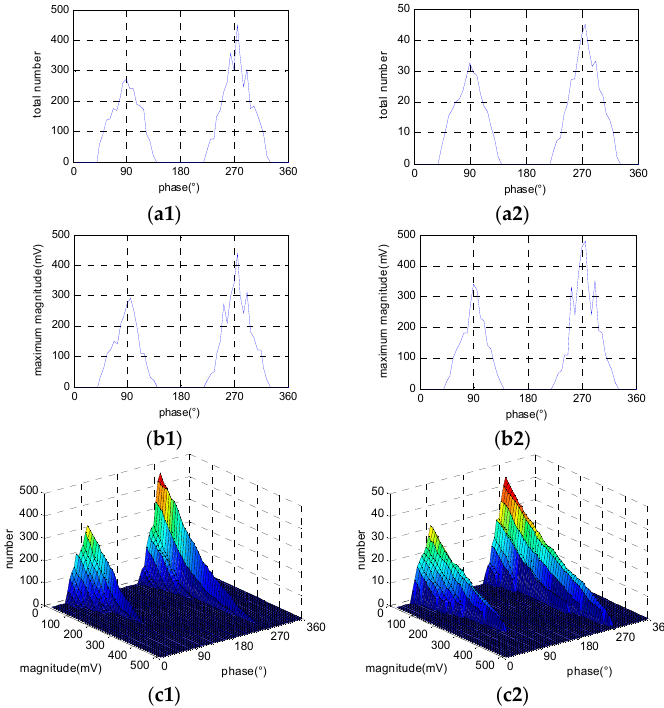
Figure 9. PD pattern charts of the corona discharge model. ( a1 )–( c1 ) are the φ ‐ n tot , φ ‐ V max , and φ ‐ V ‐ n pattern charts of data acquired by the intelligent sensor, respectively; ( a2 )–( c2 ) are the φ ‐ n tot , φ ‐ V max , and φ ‐ V ‐ n pattern charts of data acquired by the oscilloscope, respectively.